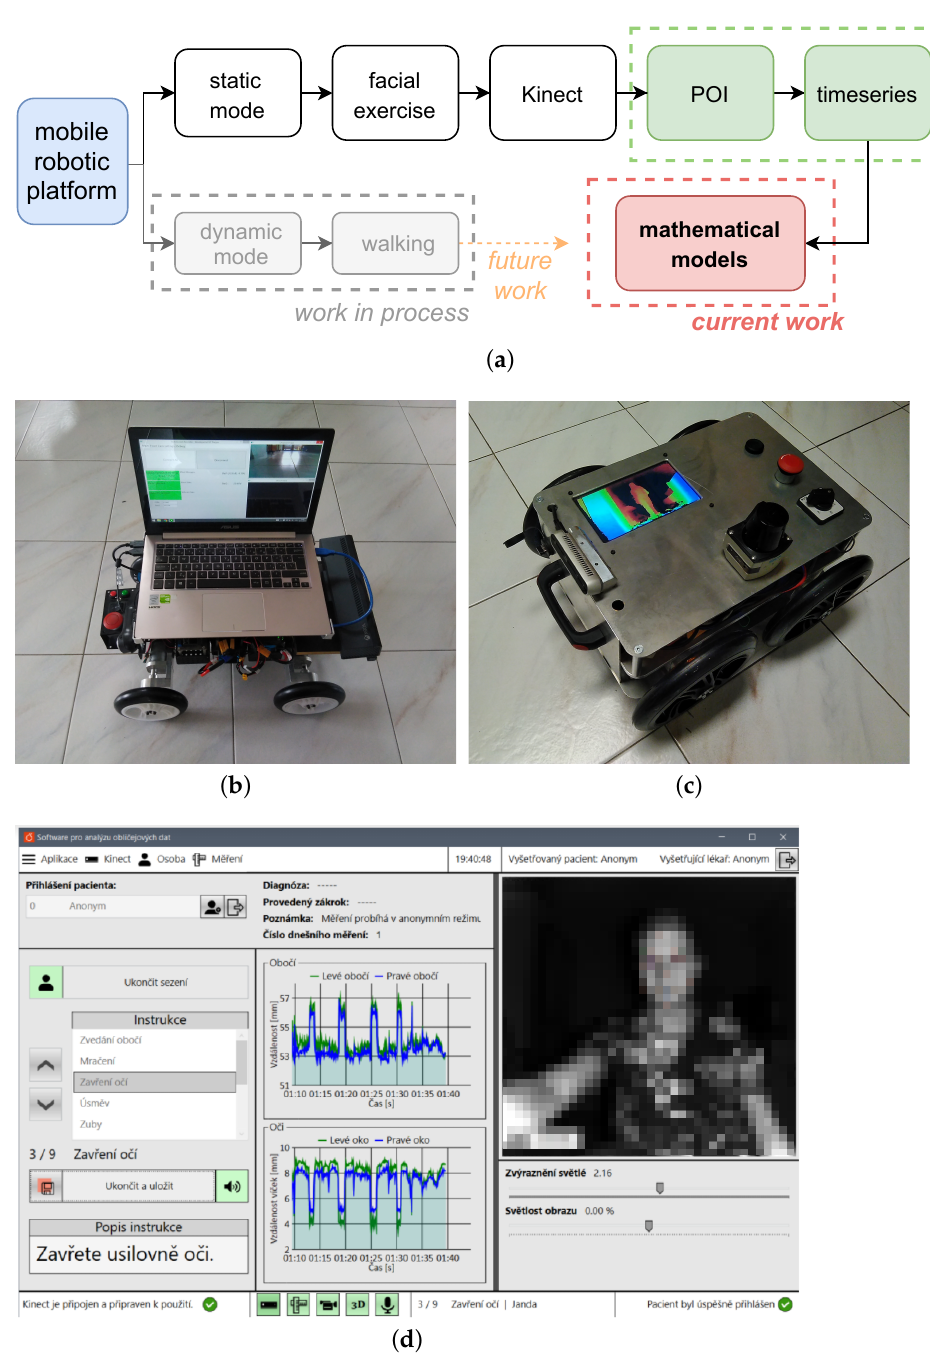
Figure 2. Scheme and an equipment for face rehabilitation measurement. Patient is measured during facial exercises in a hospital during regular check-ups. ( a ) Scheme of face measurement, ( b ) Mobile robotic platform used for face measuring (in static mode), ( c ) Last robot version for gait analysis, ( d ) A desktop application for data collection (face is in this image